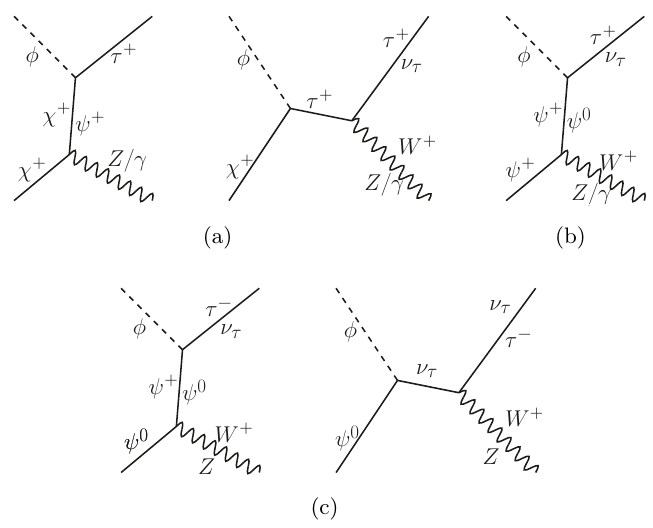
Figure 2 . Coannihilation channels that are non-trivially dependent on mixing. Figure 2(a) and 2(b) depict DM-charged fermion coannihilation whereas figure 2(c) represents DM-neutral fermion